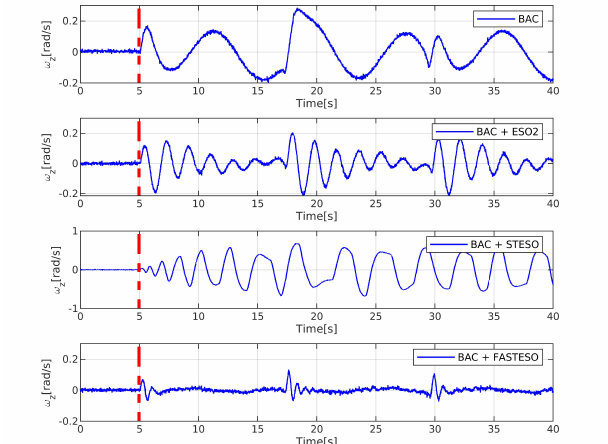
Figure 15. Results of yaw angle with unknown external torque disturbance under backstepping controller combined with nothing, ESO2, STESO and FASTESO.